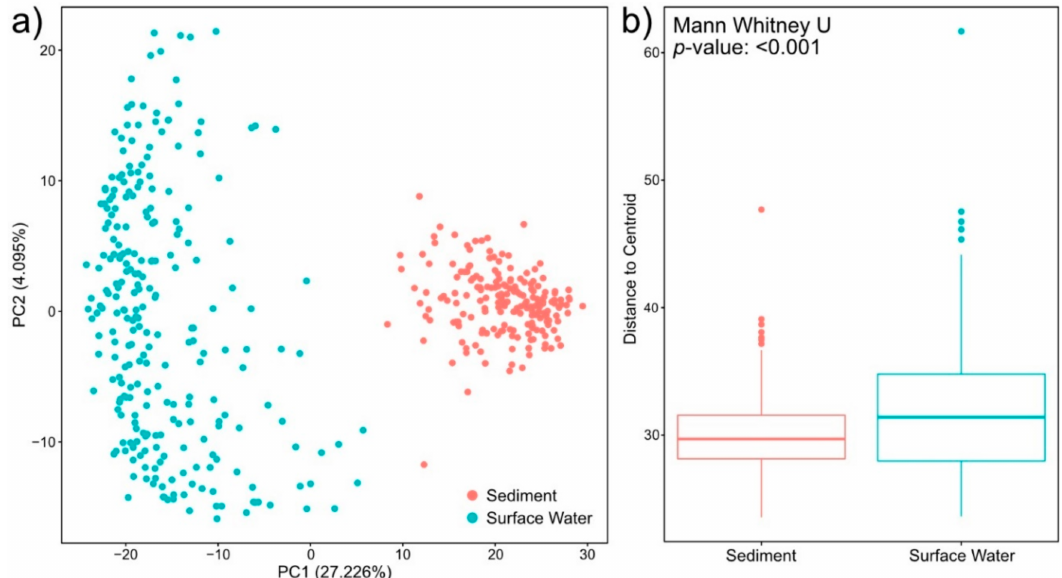
Figure 3. Principal component analysis (PCA) of the molecular formula data ( a ). Di ff erences between surfacewaterandsedimentmetabolomesweresignificantperaEuclideandistance-basedPERMANOVA ( p -value < 0.001). The degree of among-sample variation was evaluated by quantifying beta-dispersion. Surface water had higher beta-dispersion per a two-sided Mann-Whitney U test ( p -value < 0.001) ( b